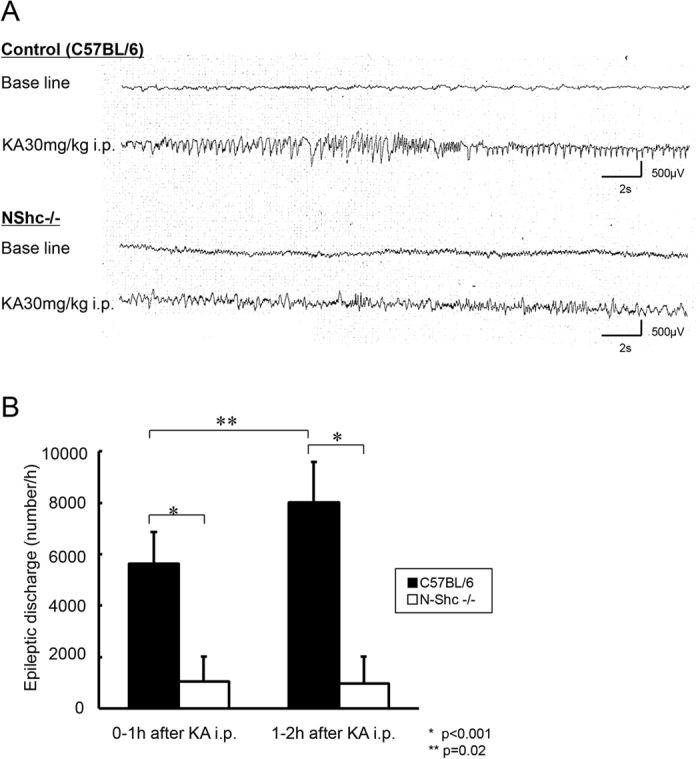
The epileptiform discharges recorded by hippocampal EEG were significantly reduced in N-Shc−/− mice.An example of the hippocampal EEG recordings registered before KA administration (base line) and during the behavioral seizures after KA administration (A). There were no obvious epileptiform discharges observed before the KA administration in either control C57BL/6 mice or N-Shc−/− mice. After KA administration, the frequency of the epileptiform discharges was significantly decreased in N-Shc−/− mice as compared with those in C57BL/6 mice within 1 hour (C57BL/6 mice n = 5, 5642.8 ± 1210 times/h; N-Shc−/− mice n = 4, 1046 ± 971 times/h; p < 0.001) and 1 ~ 2 hours (C57BL/6 mice, 8040 ± 1573 times/h; N-Shc−/− mice, 981.5 ± 1048 times/h; p < 0.001) (B). The epileptiform discharges in the C57BL/6 mice increased at 1–2 h after KA administration, whereas those in the N-Shc−/− mice were almost unchanged (p = 0.02) (B).